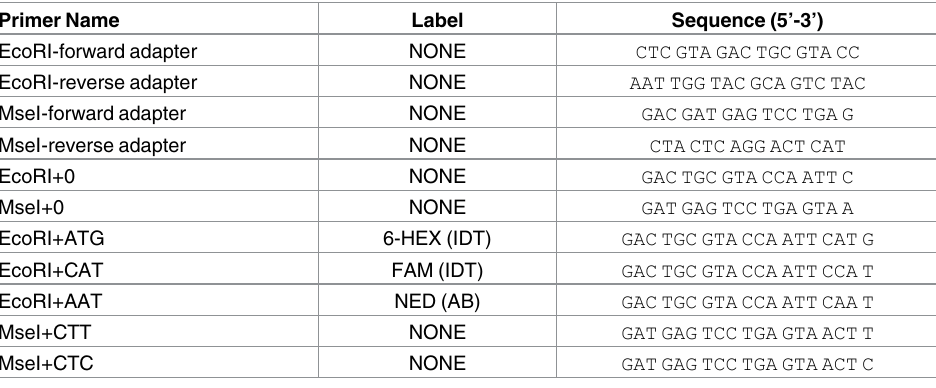
Table 2. Adapters and primers used in AFLP